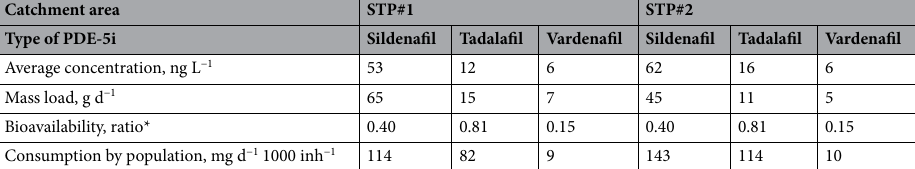
Table 2. Amounts of PDE-5i consumed in areas served by STP#1 and STP#2 estimated by mass loading, hydraulic flow and bioavailability. *Francis and Corbin